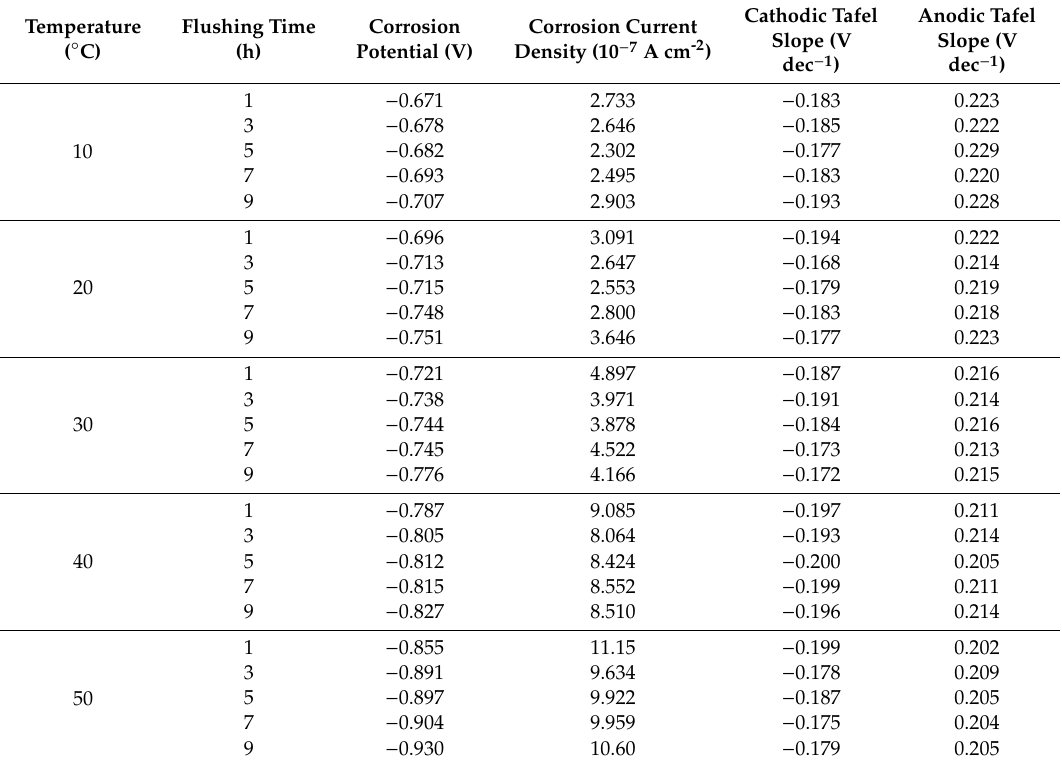
Table 1. Corrosion potentials and current densities of aluminum electrodes in deionized water at various